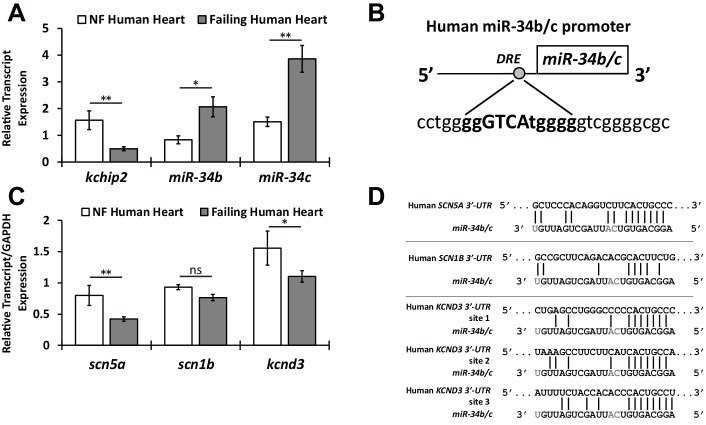
Preservation of the KChIP2/miR-34b/c axis in human heart failure.(A) Human tissue taken from the left ventricle of non-failing (NF) (n = 8) and failing patients (n = 20) evaluating KChIP2 and miR-34b/c RNA expression. KChIP2 levels were normalized to GAPDH and miR expression to small nucleolar RNA U6. (B) Evaluation of the human miR-34b/c reveals a conserved DRE motif in proximity of the miR-34b stem loop (−242 bp), as predicted by MatInspector, suggesting conservation of KChIP2 activity in the regulation of miR-34b/c expression. (C) Human heart failure tissue evaluating RNA levels for SCN5A, SCN1B, and KCND3. Significant reductions in heart failure samples (n = 20) were observed for SCN5A and KCND3, but not for SCN1B, compared to non-failing tissue (n = 8). (D) Alignment of the 3’-UTR of SCN5A, SCN1B, and KCND3 genes with miRs-34b/c from human. Grayed letters indicate variation in sequence between miR-34b and −34c. A single site of interaction is indicated for SCN5A, matching observations in the rat, while KCND3 has three potential sites, compared to two observed in the rat. Notably, SCN1B miR-34b/c targeting is not conserved in human shown by imperfect hybridization in the seed region. Data presented as mean ± SEM. *p<0.05; **p<0.01, as indicated or compared to control. #p<0.05, ##PP<0.01 compared to PE+Ad.GFP.